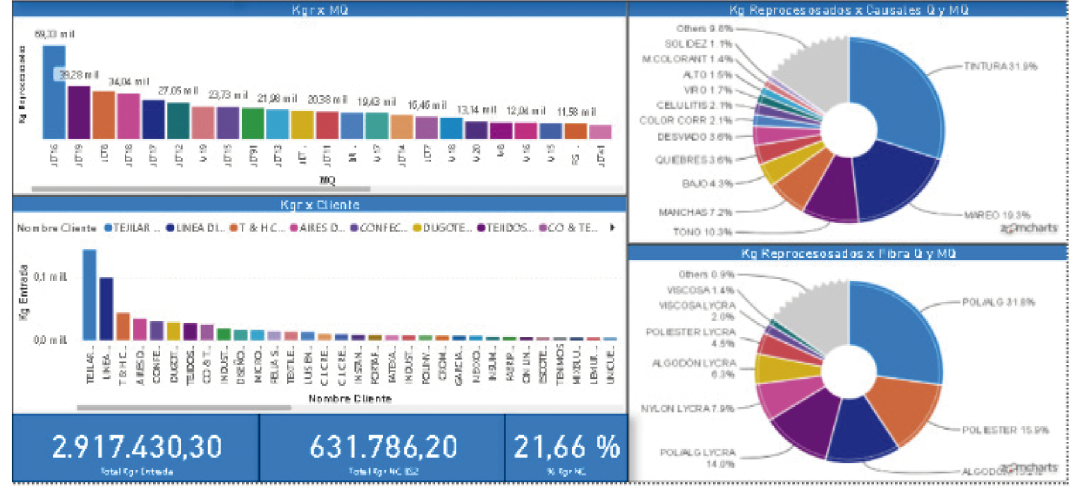
Figure 10. dashboard of kilograms reprocessed in the industrial